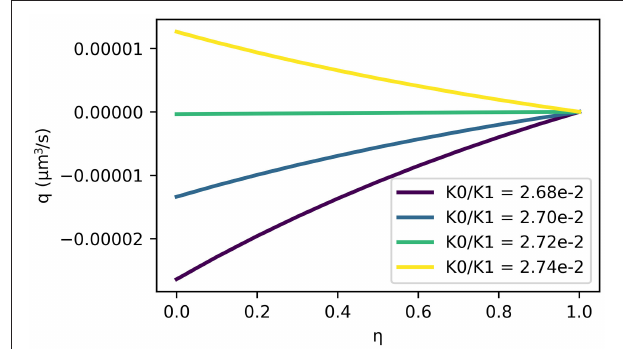
FIGURE 5 | ISF flux (positive values in the direction of arterial flow) averaged over one cycle as a function of BM position η in the arterial wall. Here, the BM r 0 η h such that η is at r 0 represents a BM immediately adjacent to the = + = lumen and η 1 represents a BM on the outer wall of the artery. Note that = reverse flow is only achieved by ratios of K 0 / K 1 < 2.74 10 − 2 . The fastest × net reverse drainage shown here (for K 0 / K 1 2.68 10 − 2 and on the arterial = × lumen η 0) is -2.64 10 − 5 µ m 3 s − 1 = ×